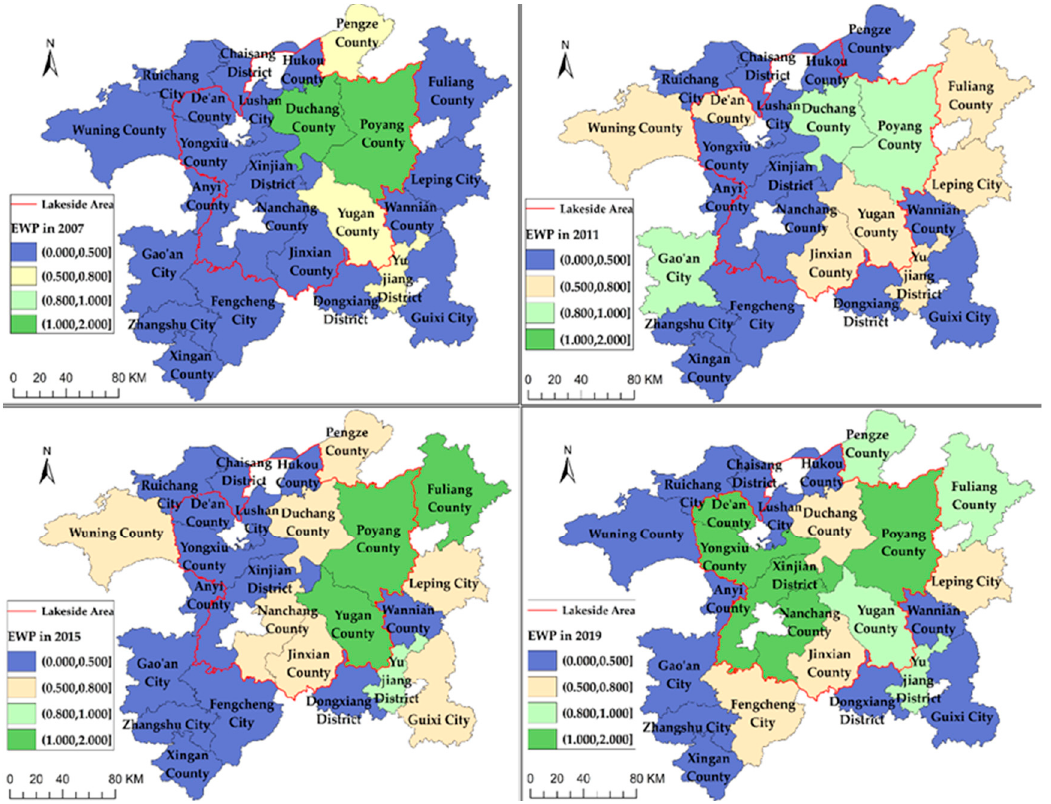
Figure 4. Spatial distribution of EWP in the Poyang Lake area from 2007 to 2019.